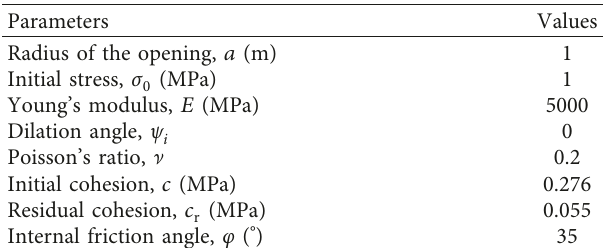
Table 4. From the above two figures, it can be seen that once